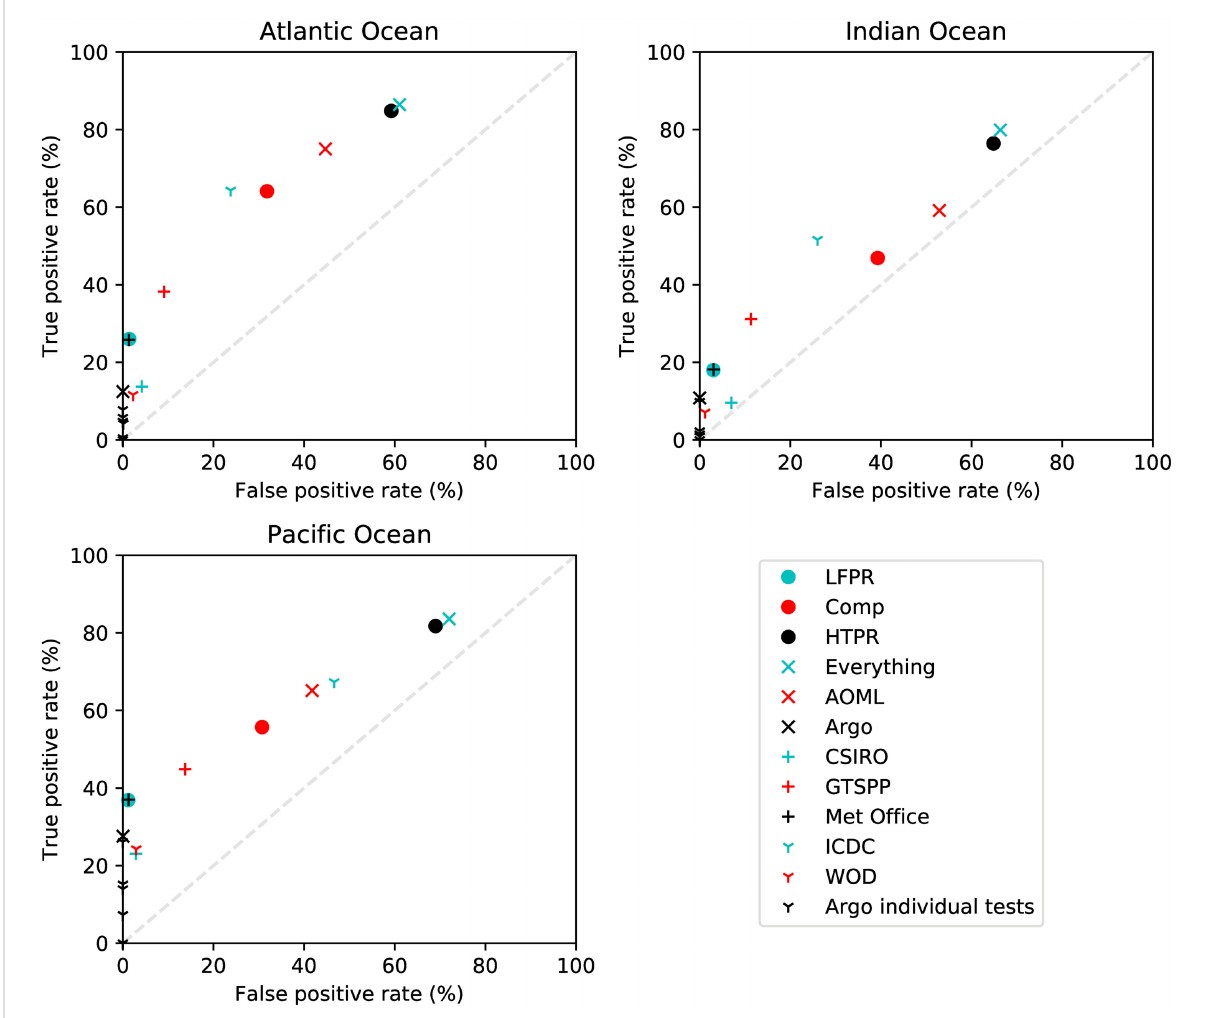
FIGURE 9 TPRs and FPRs for different QC sets calculated from delayed mode Argo data in the Atlantic, Indian and Paci fi c ocean regions. End points of pro fi les were removed before generating the results. The results for individual Argo QC tests are also shown including the Min/Max test as this was designed for application to Argo data. A line showing equal TPR and FPR is drawn to aid comparison of